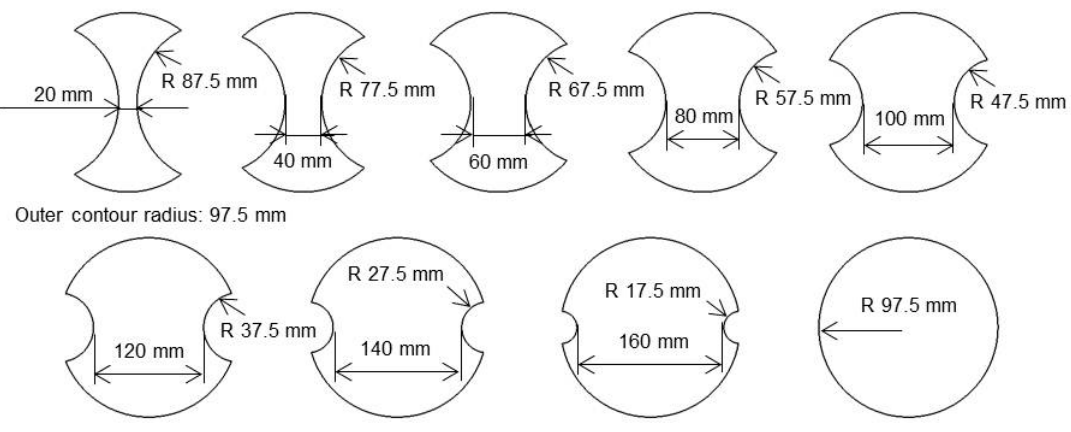
Figure 4. Nakazima cup test specimens.